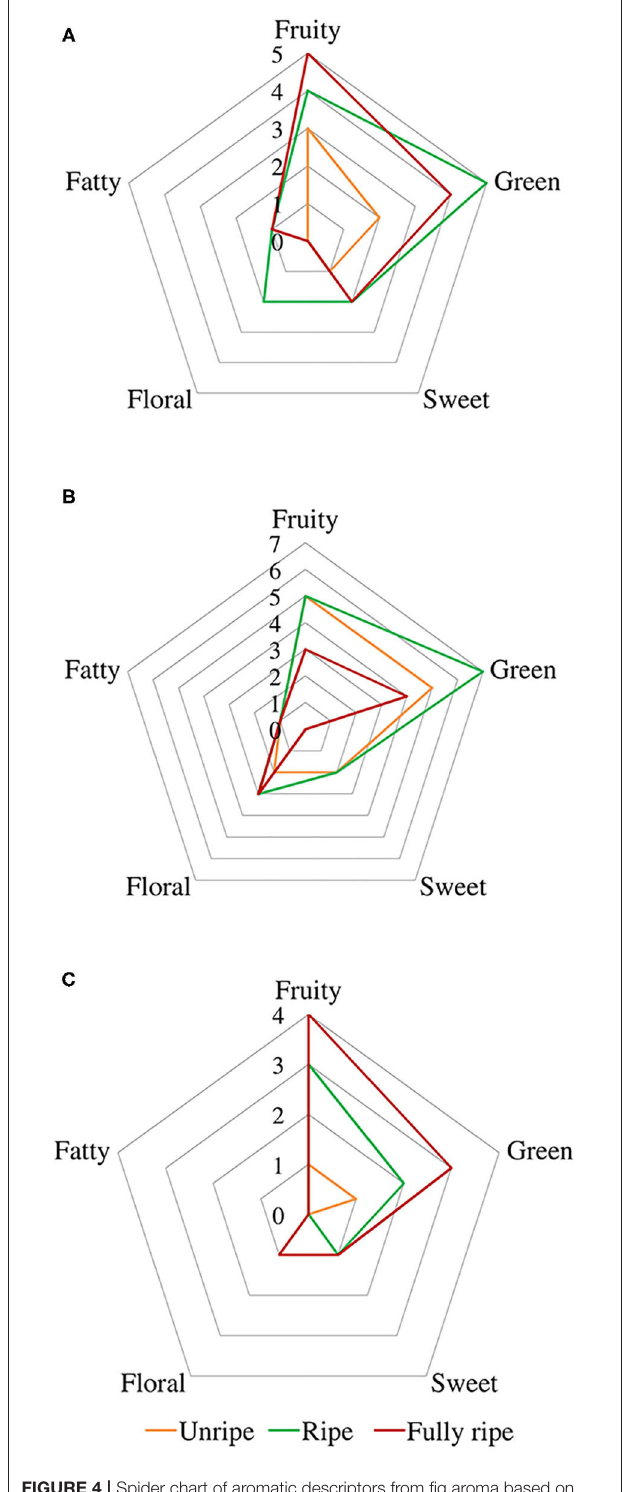
FIGURE 4 | Spider chart of aromatic descriptors from fig aroma based on their odor thresholds. Cultivars (A) Taamriwthe, (B) Azegzaw, and (C) Averkane. The presentation consists of equiangular spokes, where each spoke representing one descriptor, and the position of the spot on the spoke was proportional to the value of the corresponding